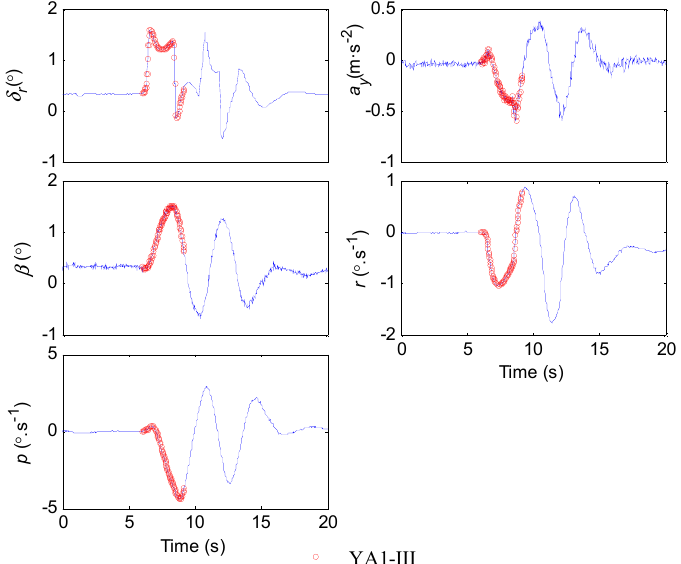
Figure 10. Data segments of response of rudder 3-2-1-1 input for side force derivative identification.